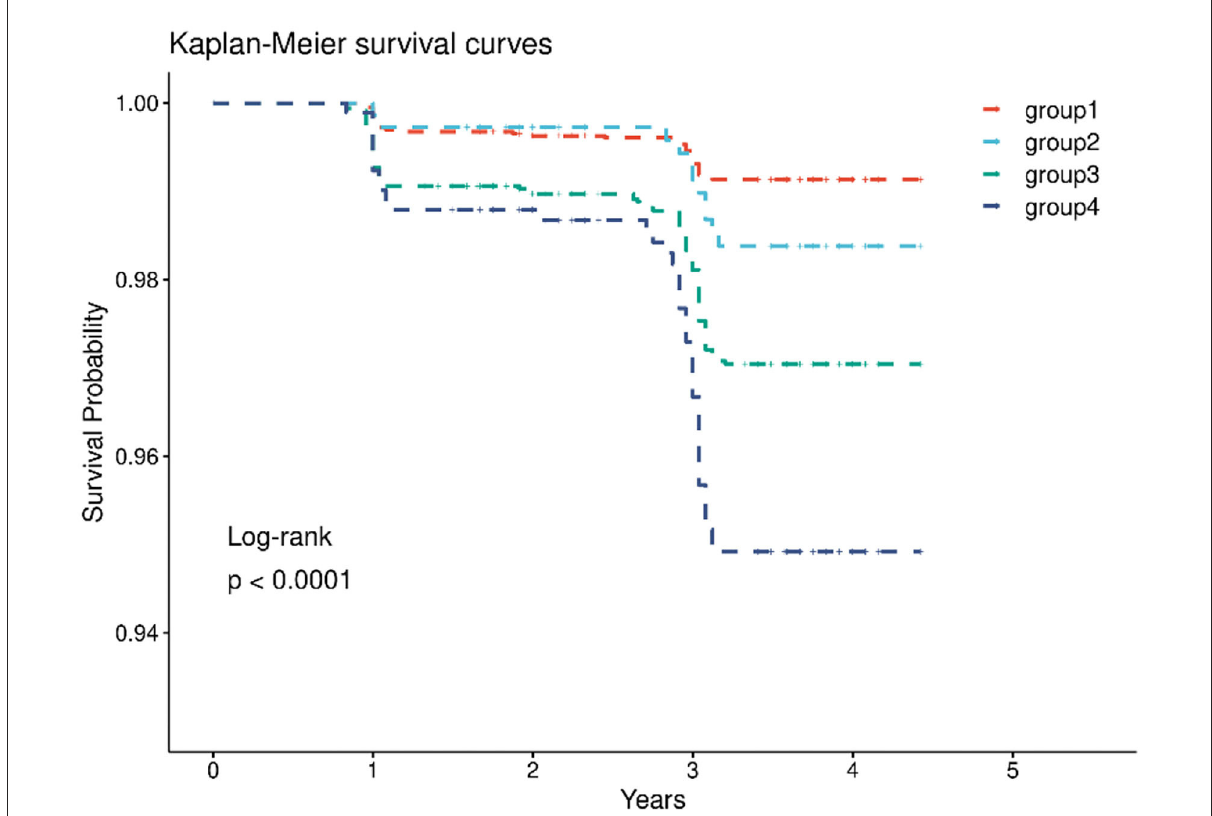
FIGURE2 Kaplan–Meier survival curves for the stroke in four groups in